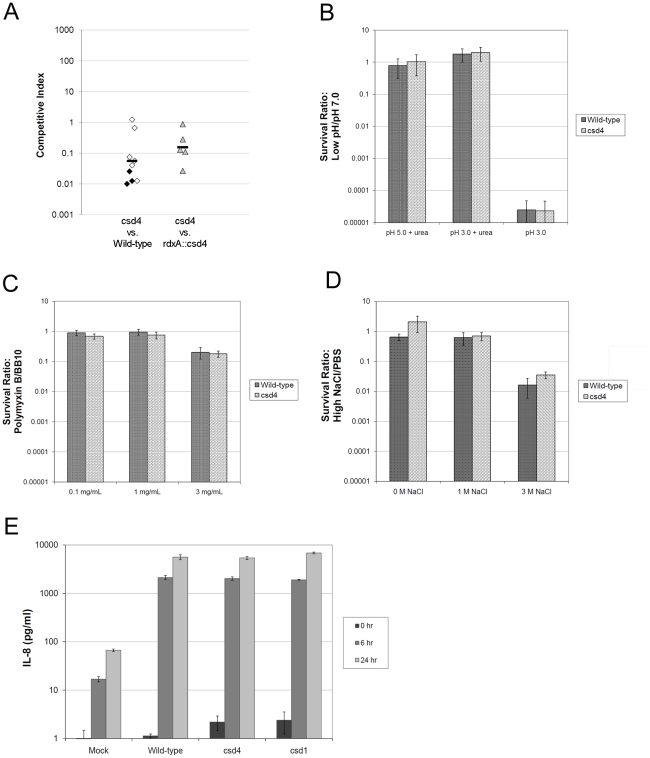
Assessment of the straight rod H. pylori's colonization and pro-inflammatory potential.A) One week C57BL/6 mouse competition data compiled from three independent experiments. Data are plotted as a competitive index: [CFU/mLMUT∶CFU/mLWT/Complement stomach output]/[CFU/mLMUT∶CFU/mLWT/Complement inoculum] with each data point representing a single mouse. Black points indicate mice from which only one strain was recovered. Strains used: LSH100, LSH122, LSH124. B–D) Survival at low pH (B), in the presence of polymyxin B (C), or in high salt (D). Data comprise two independent experiments of four replicates per strain and condition (mean ± SD). Strains used: NSH57, LSH18. E) IL-8 production during infection of AGS gastric epithelial cells. Culture supernatants of triplicate wells were assayed for IL-8 using a commercial ELISA assay after infection at a multiplicity of infection of 10 (mean ± SD). Shown are data from one of three independent experiments with similar results. Strains used: NSH57, LSH13, LSH18.